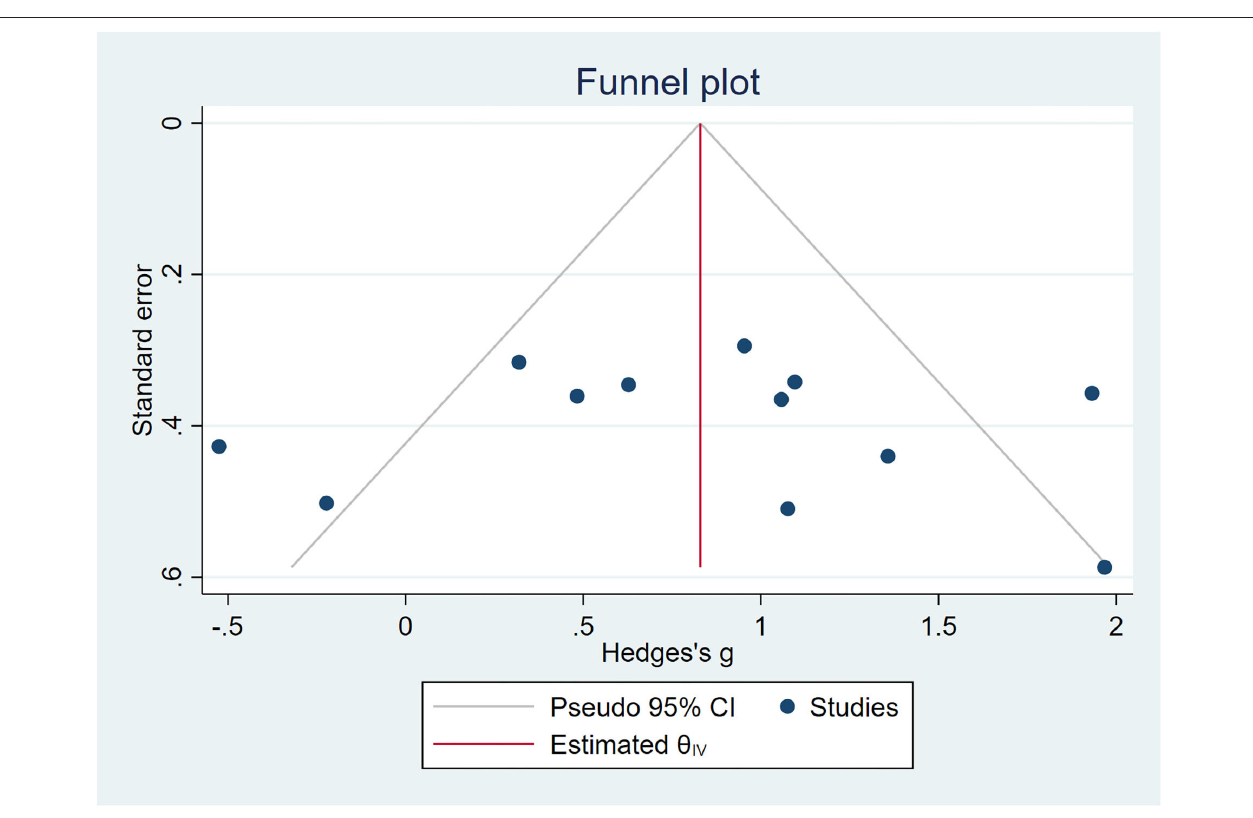
than control interventions (SMD p < 0.00001) ( Figure 7